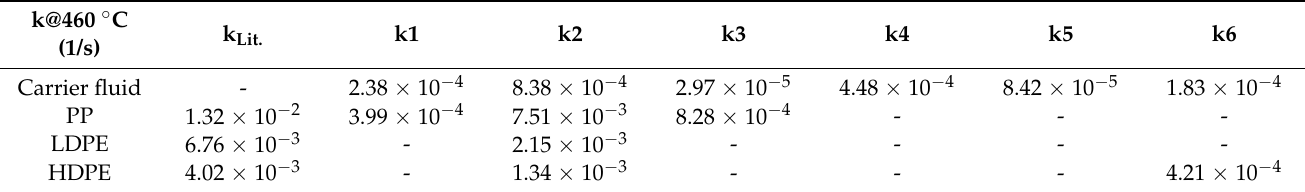
Table 4. Reaction rates at 460 °C of all determined reactions and the used plastic decomposition reactions “k Lit. ” from [15]. k@460 ◦ C